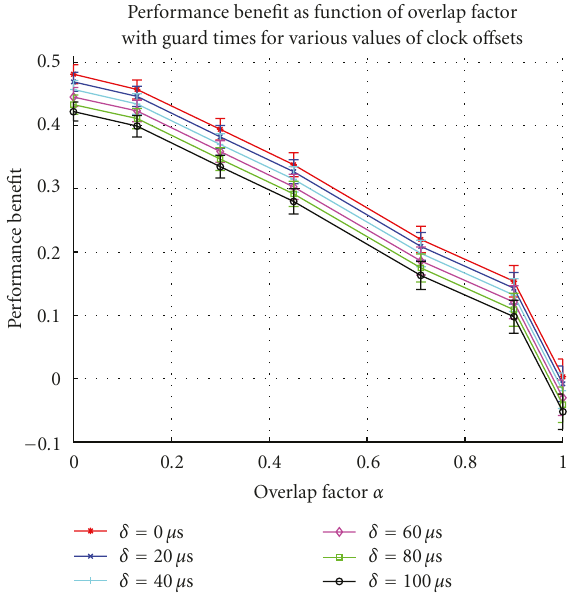
Figure 15: Performance gain through simulation for n = 5 for varying overlap factor α with guard times based on di ff erent